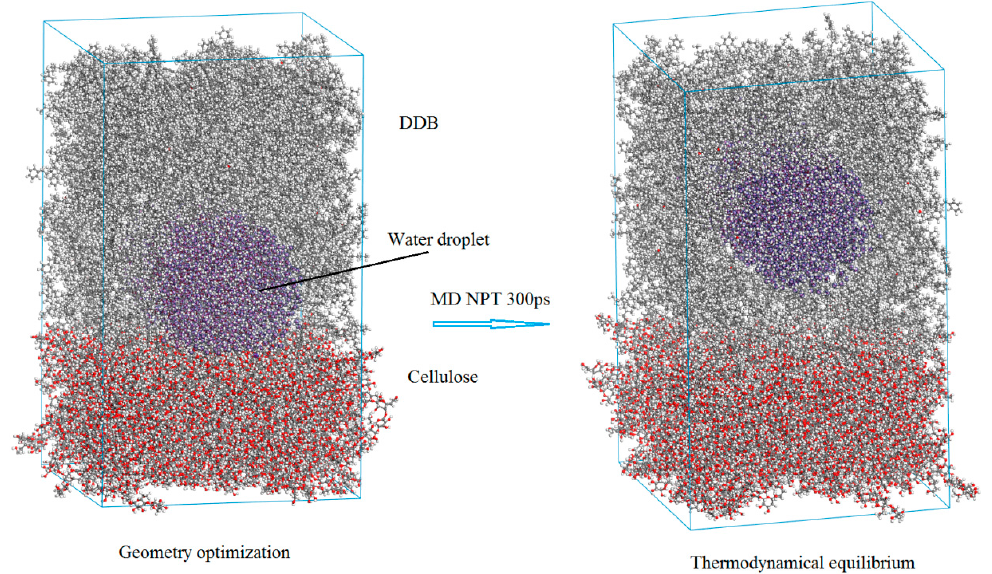
Figure 4. The initial geometrically optimized configuration ( left ) and phase equilibrium ( right ) of modeled H 2 O/DDB/cellulose 3-phase system for oil-impregnated pressboard.